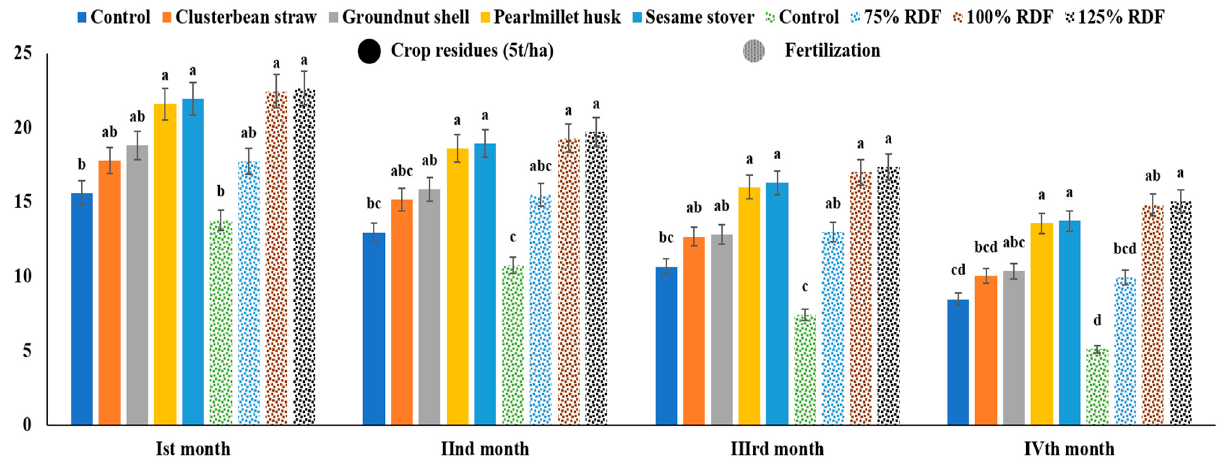
Figure 3. Effect of crop residues and fertilization on microbial biomass phosphorus (µg g − 1 ) at first,